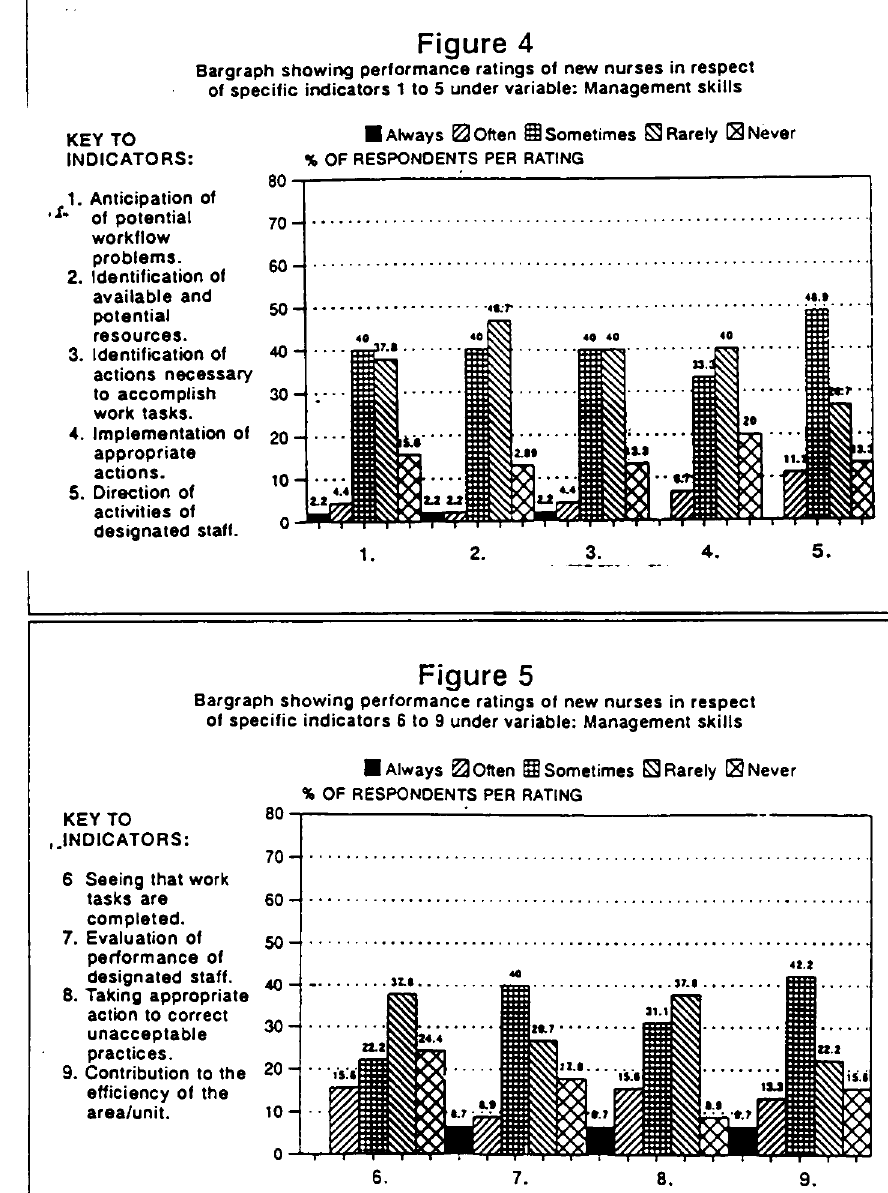
TABLE 2 : THEMES OF WEAK POINTS IN THE PERFORMANCE OF NEWLY QUAUFIED